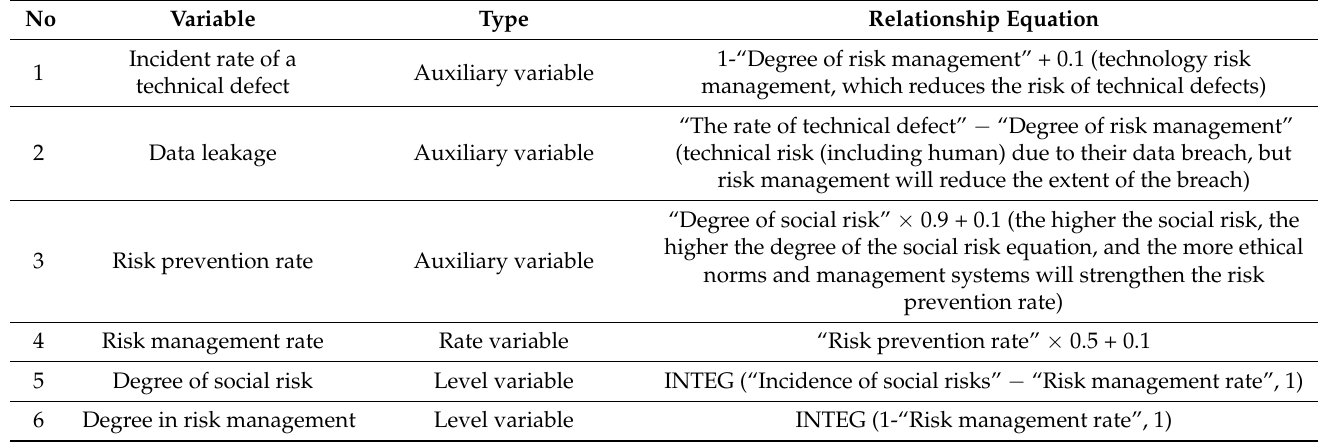
Table 4. Ethical risk governance variables and equations for AI decision